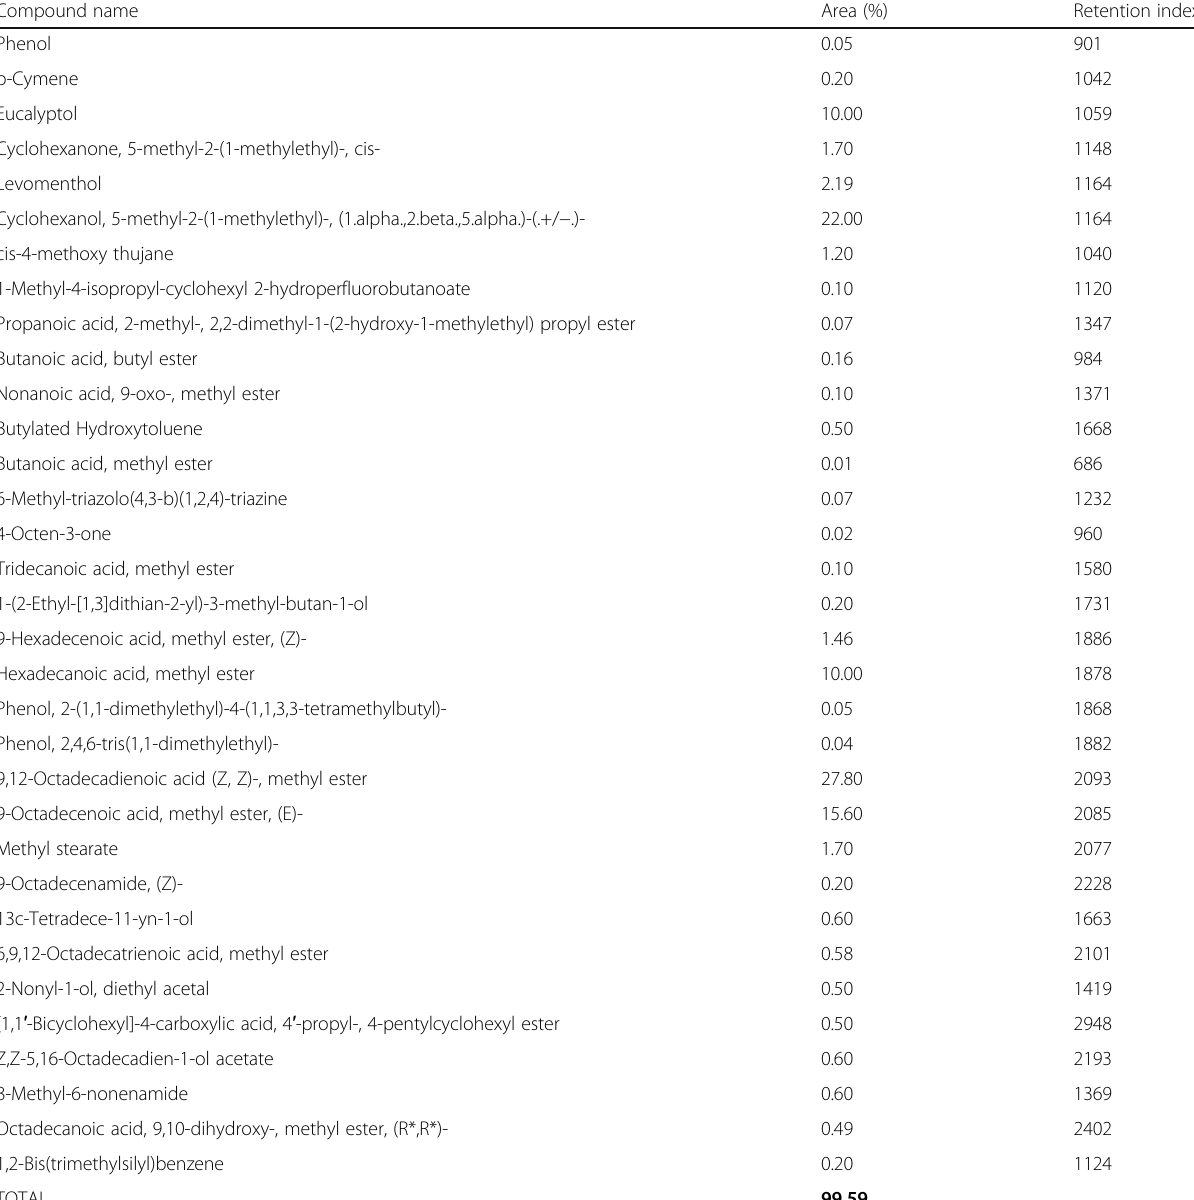
Table 8 Compounds detected in the ethanol extract of Nigella sativa by GCMS Compound